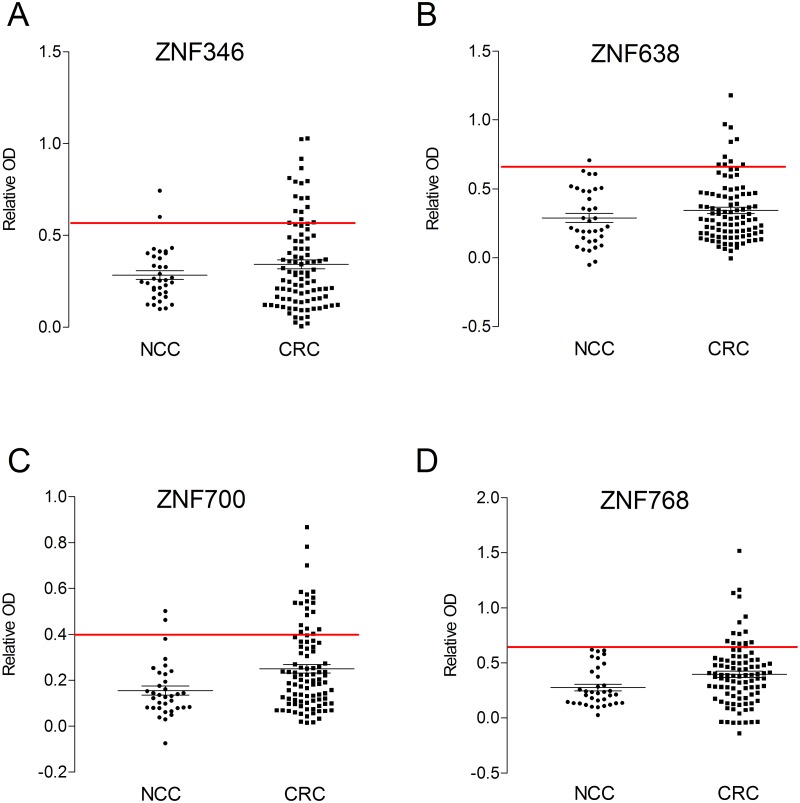
Relative OD autoantibody signals detected in CRC and NCC sera by indirect ELISA.Zinc finger proteins (A) ZNF346, (B) ZNF638, (C) ZNF700 and (D) ZNF768 were used as capture antigens. Black line represents the average of relative ODs (optical density) within each patient cohort. Red line represents ELISA cut-offs calculated as the average of NCC relative OD values +2SD. CRC: colorectal cancer, NCC: non-cancer control.